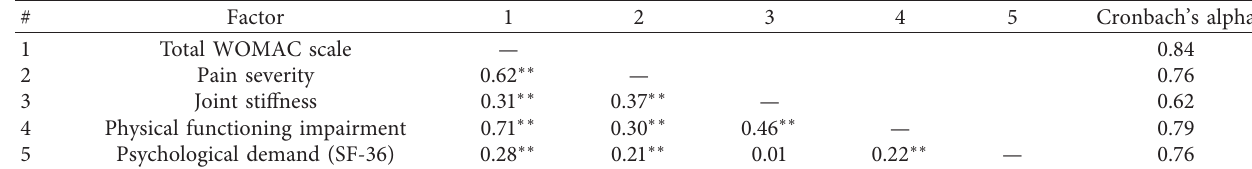
Table 1: Correlation coefficients and Cronbach’s alpha for the scales used in this